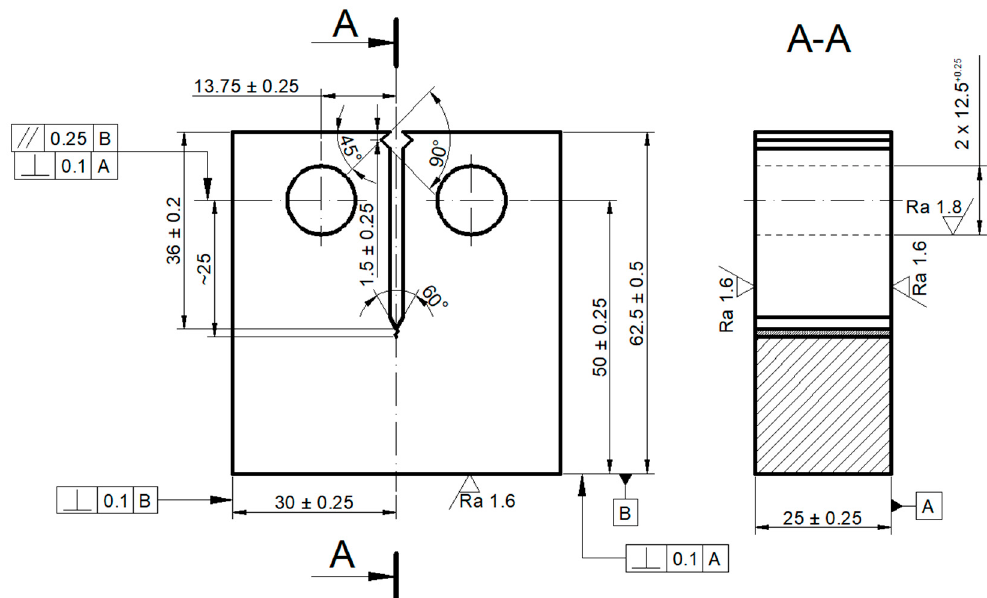
Figure 2. C(T) specimen drawing (dimensions are in mm), according to the ASTM E 399 standard